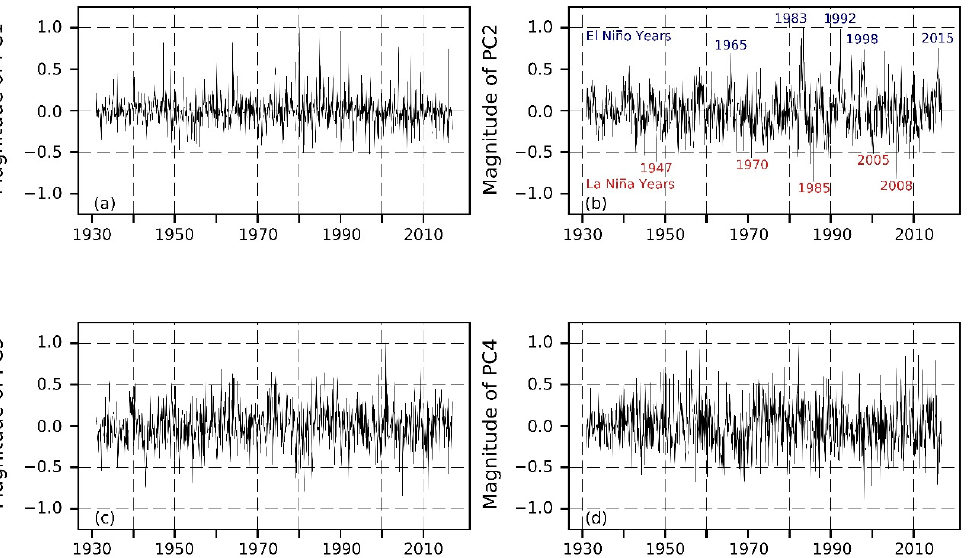
Figure 5. ( a ) Normalized PC1 time series; ( b ) Normalized PC2 time series. Blue labels indicate El Niño events and red labels indicate La Niña events; ( c ) Normalized PC3 time series; ( d ) Normalized PC4 time series. The PC time series is normalized such that the maximum value is +1.